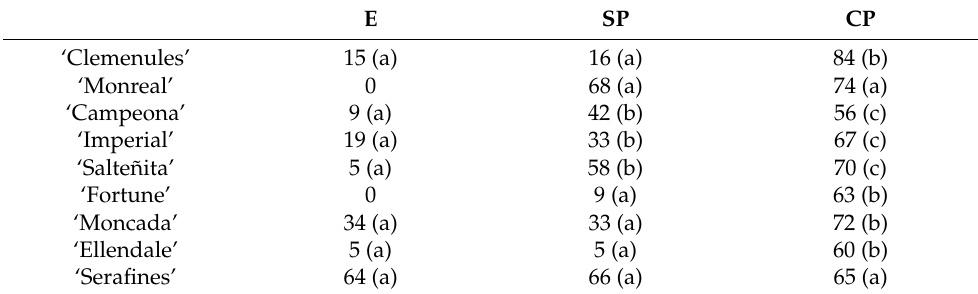
Table 2. Fruit setting percentage obtained in each